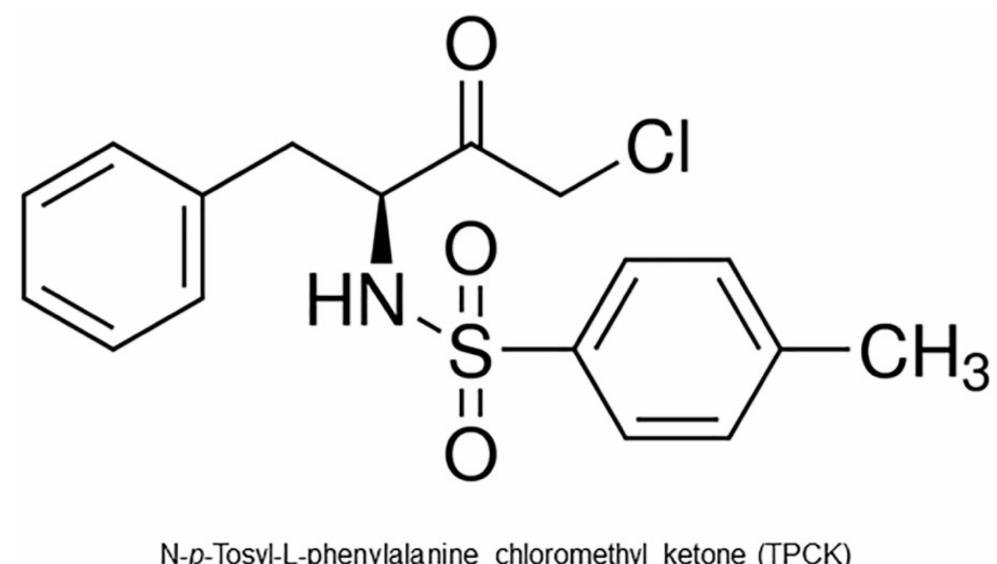
Figure 1. Chemical structure of N- p -Tosyl-L-phenylalanine cloromethyl ketone